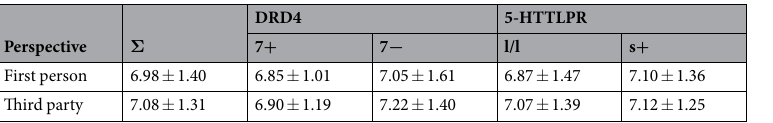
Table 2. Descriptive data for individual fairness norms (in €). Data are presented as mean ± standard deviation and represent individual fairness norms for a hypothetical dictator assignment that is considered neither fair nor unfair by the average participant in the respective